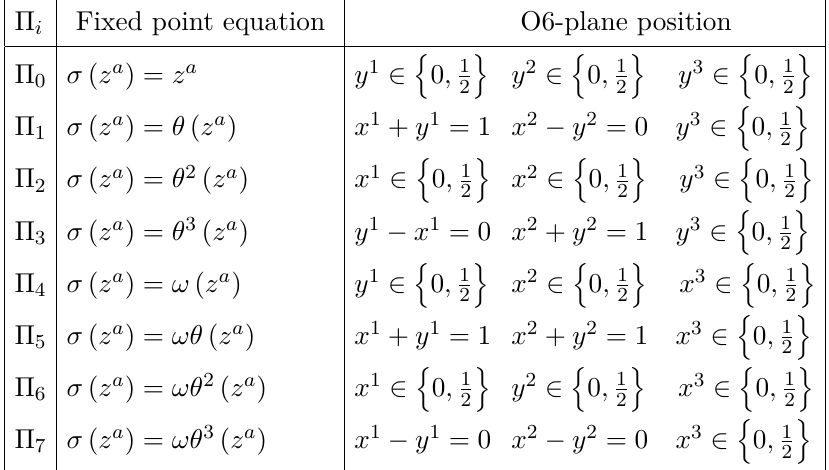
Table 5. O6-planes in T 6 / Z 2 × Z 4